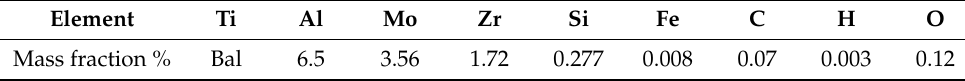
Table 1. Chemical composition of TC11 titanium alloy powder (wt%).